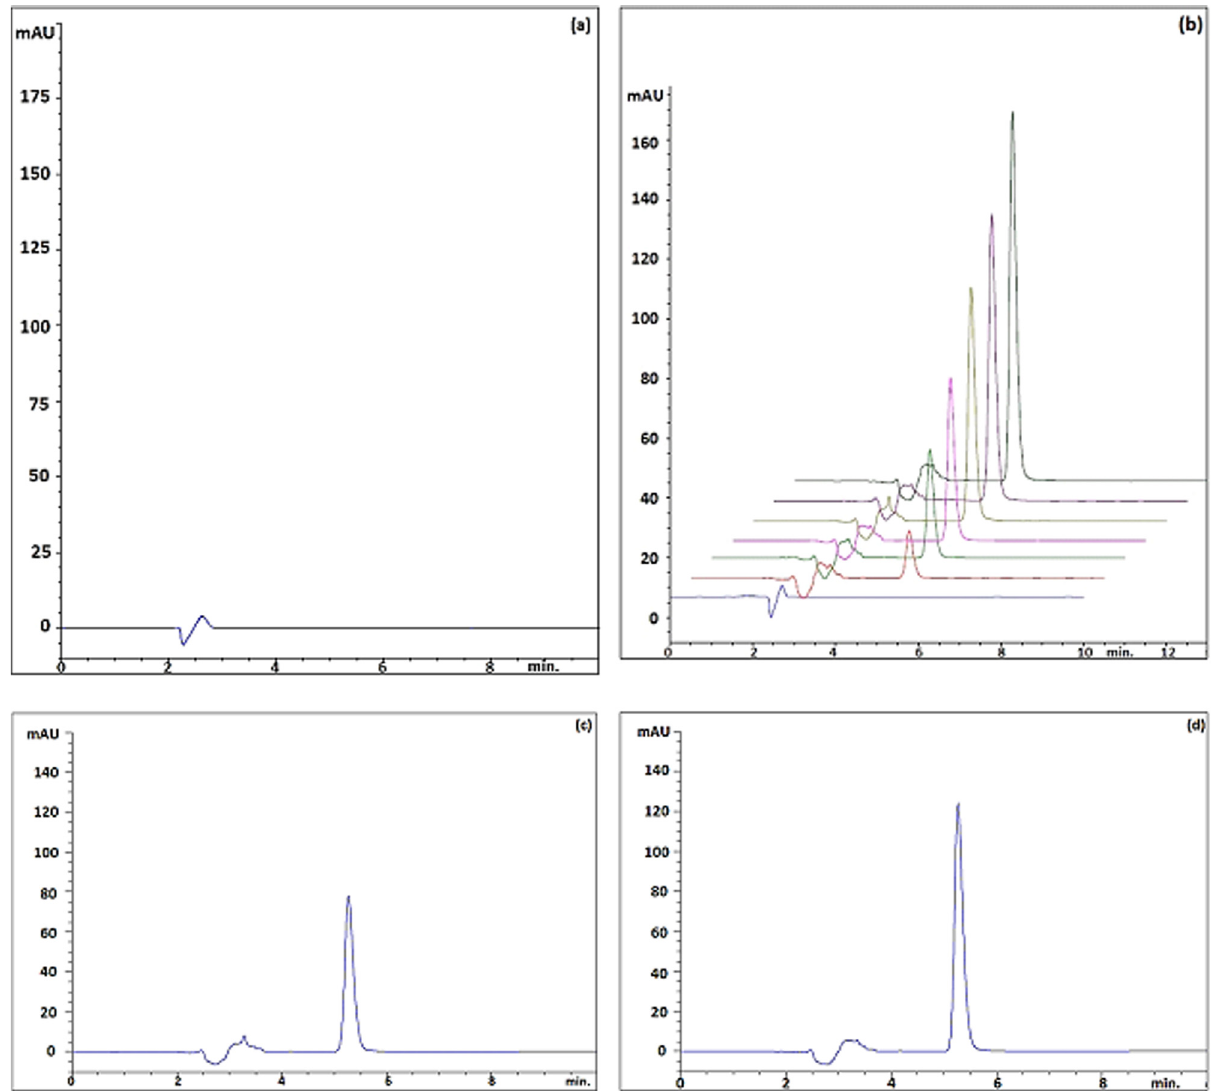
Figure 2: ( a ) HPLC chromatogram of blank, ( b ) standard solutions ( 5 – 30 µg · mL − 1 ) , ( c ) pharmaceutical product ( 20 µg · mL − 1 ) , and ( d ) standard solution ( 30 µg · mL − 1 )